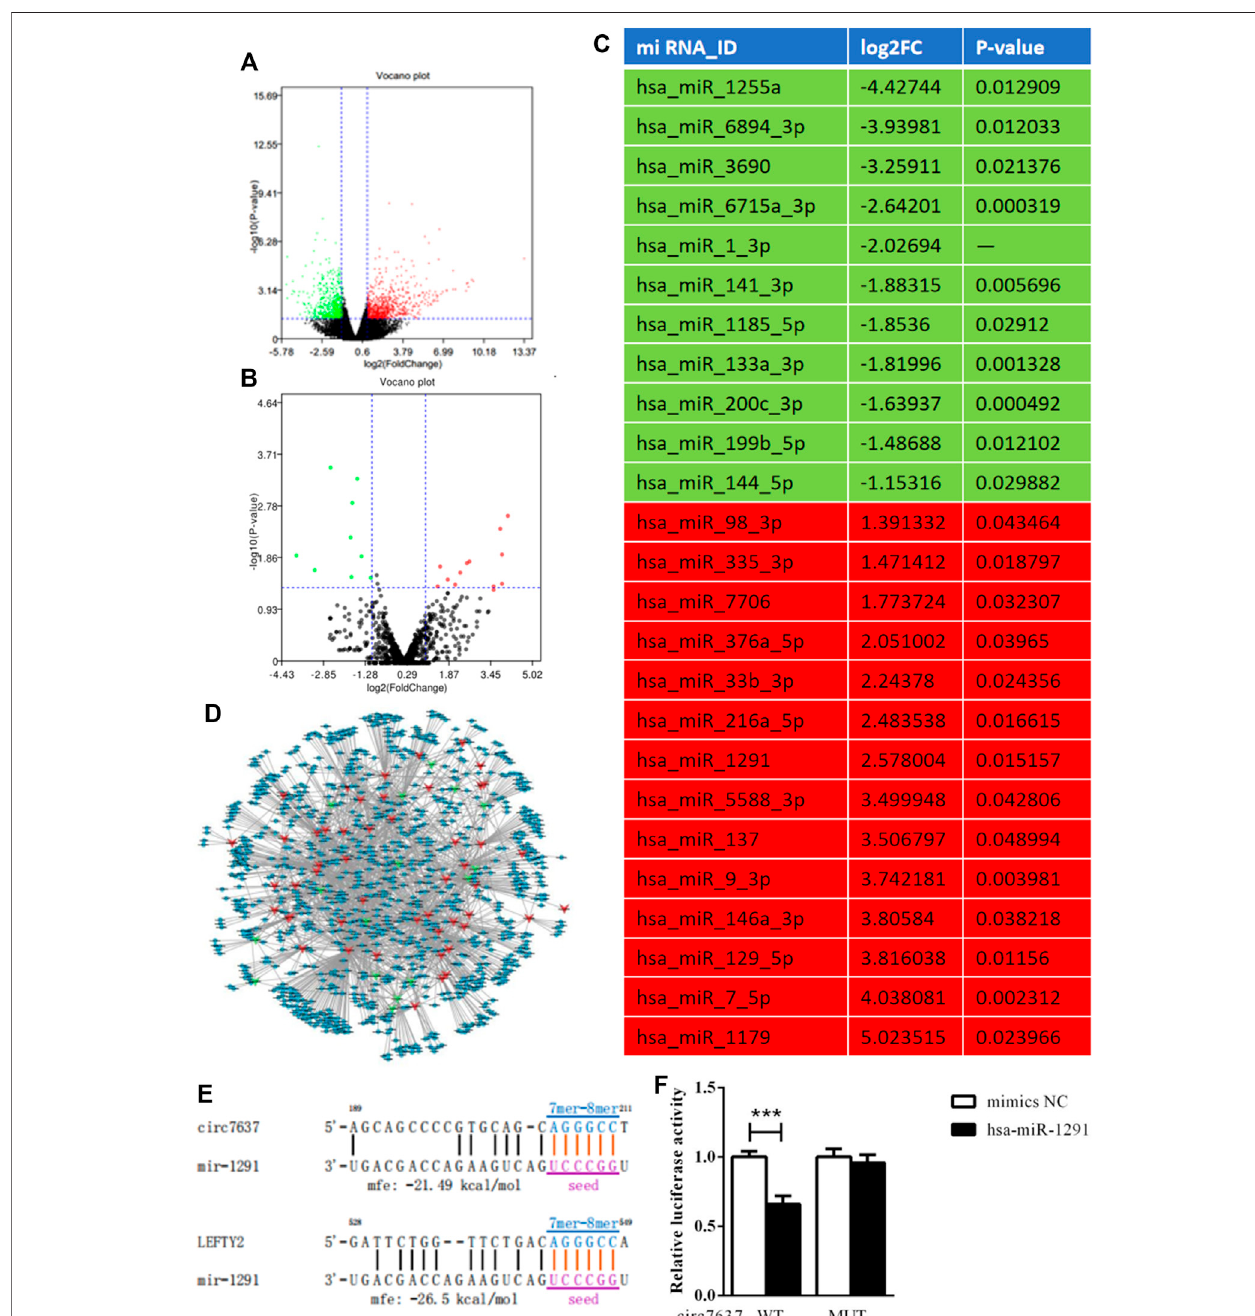
FIGURE 6 | Microarray analysis and identi fi cation of circCREBBP-hsa-miR-1291 connectivity. To assess the potential miRNAs bind to circCREBBP, and identify promisingnovelmiRNAs relate toHF, miRNA expressionpro fi le inHFtissues wasanalyzed bymicroarray.Importantly,wefound14miRNAs downregulatedinHFmice, along with 11 miRNAs upregulated in HF mice (A – C) . Network based on the correlations between differentially expressed miRNAs and their differentially expressed circRNAtargetswasshowedinadiagram (D) .Basedonsequencepairing,bindingsitesofhsa-miR-1291wereidenti fi edwithinthecircCREBBPsequences (E,F) .